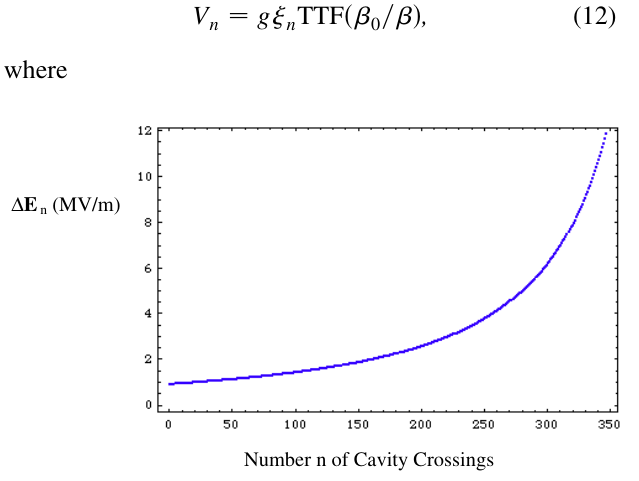
FIG. 4. (Color) Energy gain (cid:1) E vs number n of cavity crossings.